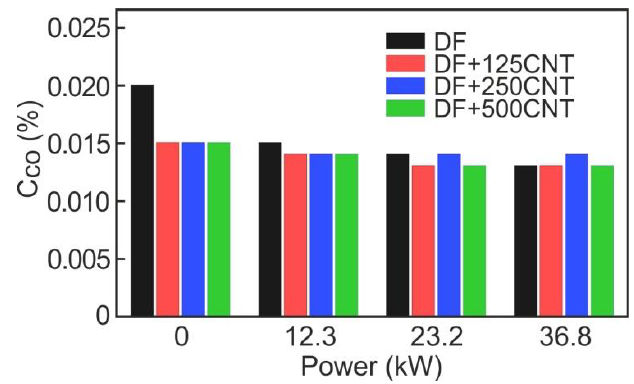
Figure 7. Change in carbon monoxide ( C CO ) in exhaust gas depending on the amount of CNT addition at different diesel engine loads.